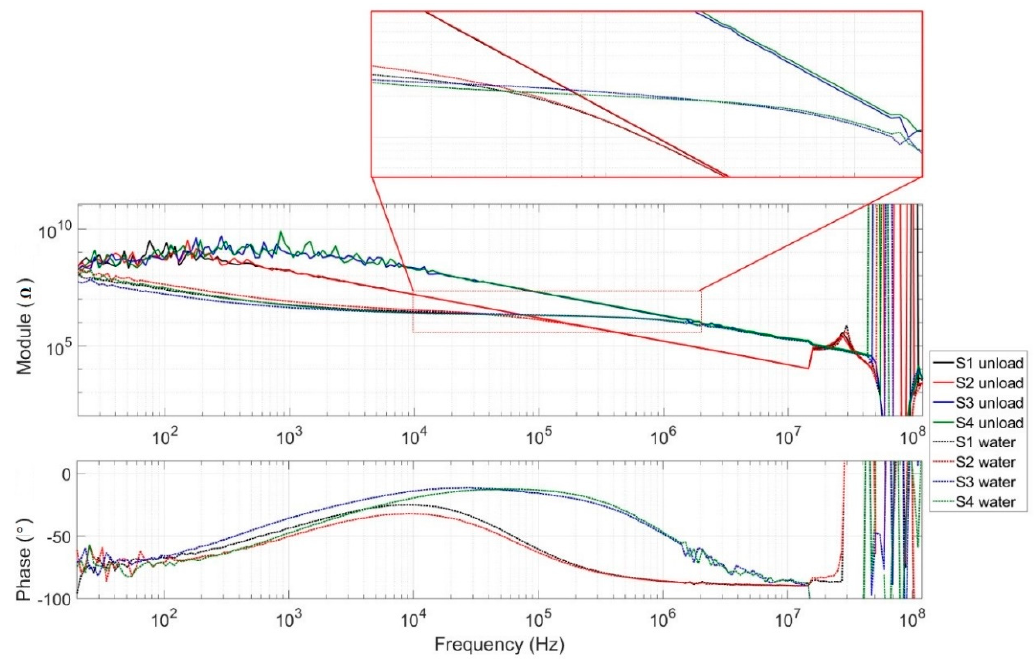
Figure 6. Measured impedance module and phase of the new and the previous generations of unloaded sensors.